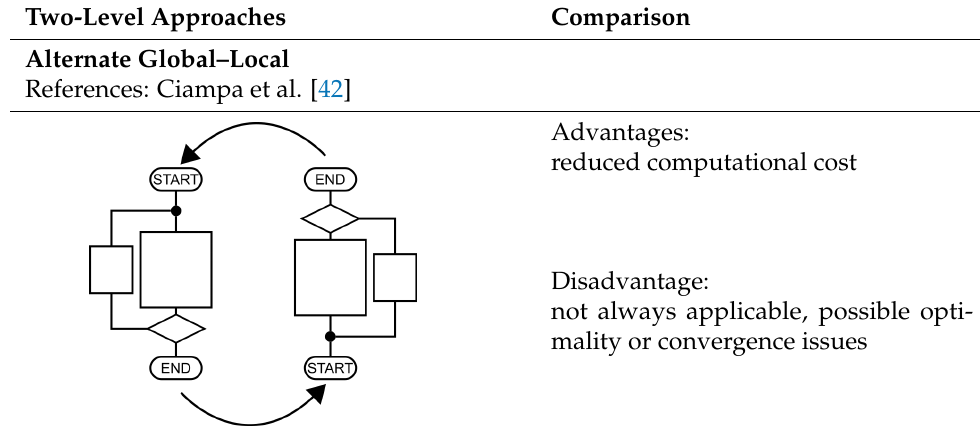
Table 1. Comparison of two-level